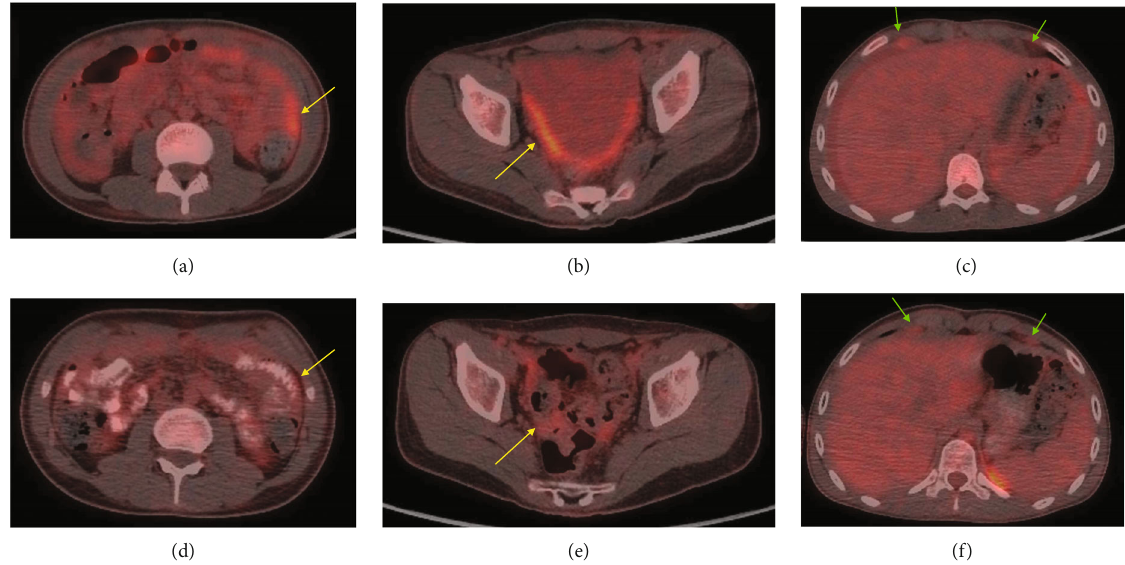
Figure 8: Top images (a – c): initial PET/CT demonstrating FDG avid thickening of the peritoneum and omentum (yellow arrows) and FDG avid nodules along the anterior diaphragm (green arrows). Bottom images (d – f): PET/CT 2 months later with decreased FDG avidity of the peritoneum and omentum (yellow arrows) and nodules along the anterior diaphragm (green arrows).